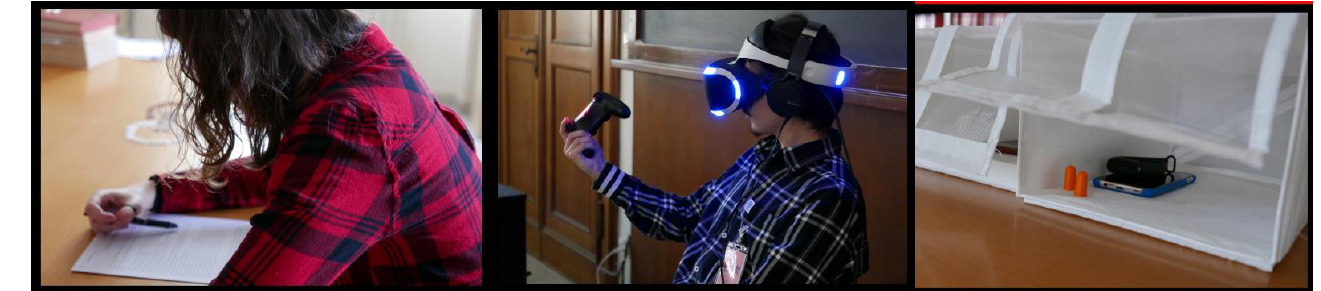
Figure 2. Focus Exercise ( left ); playing the game exercise ( center ); phones and watch left by partic- ipants ( right ).